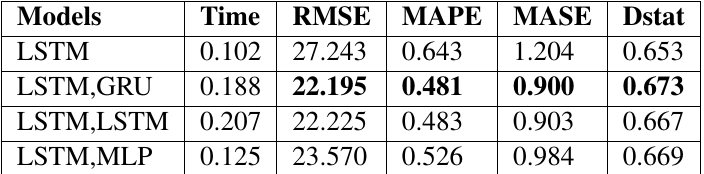
Table 1 The experiment results (NN1: LSTM, DATA SET: